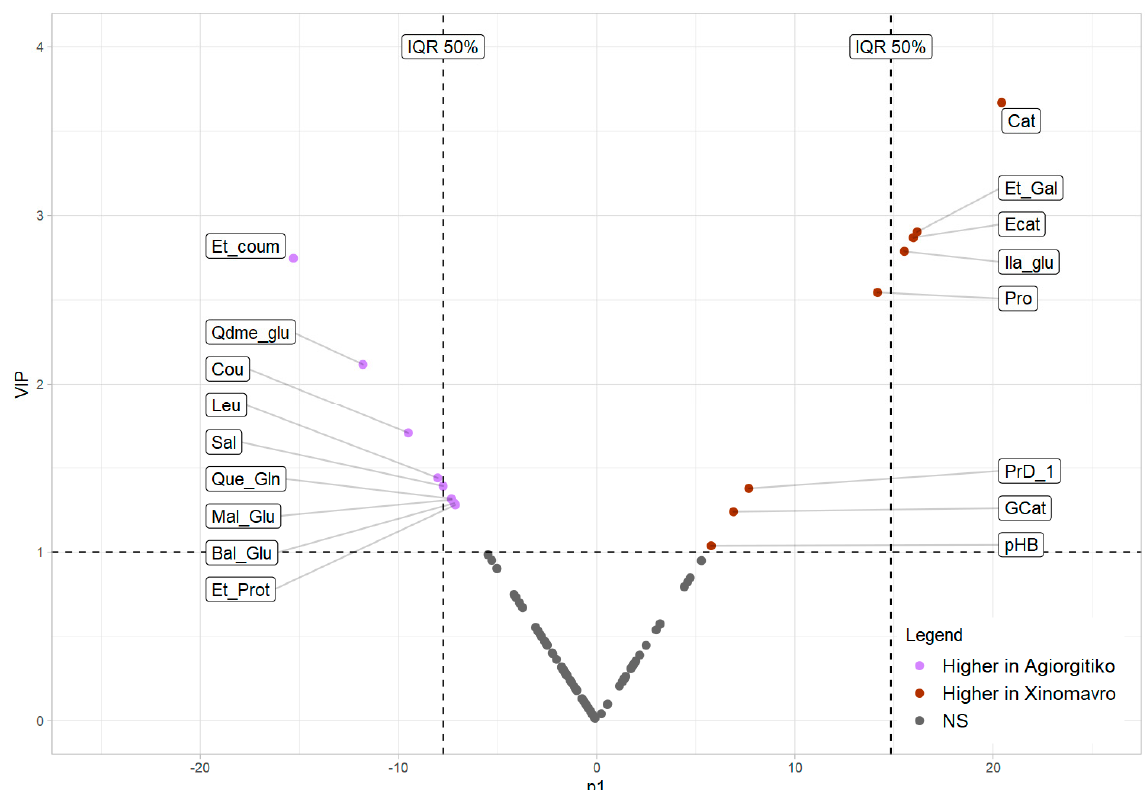
Figure 5. Vplot combining the modeled covariance (p1) and the VIP values of the OPLS DA model. Datapoints in purple are more associated with Agiorgitiko wines while the ones in red are more expressed in Xinomavro wines. Abbreviations Sal:Salicylic acid; Bal_Glu: Benzyl O-[arabinofuranosyl-(1->6)-glucoside]; Cou: Coutaric acid; Que_Gln: Quercetin.3.glucuronide; Et_coum: Ethyl.coumarate; Et_Prot: Protocatechuic acid ethyl ester; Cat: Catechin; Ecat: Epicatechin, pHB: p-Hydroxybenzaldehyde; Et_Gal: Ethyl.gallate; PrD_1: Procyanidin dimer 1, GCat: Gallocatechin; Pro: L-Proline, Ila_Glu: Indolelactic acid glucoside, Qdme_glu: Quercetin 3,3 ′ -dimethyl ether 4 ′ -glucoside; Leu: (Iso)-Leucine; Mal_Glu: Malvidin 3-O glucoside; IQR50% Optional threshold based on the application of the IQR method to reduce the number of important markers by 50% while retaining model accuracy.